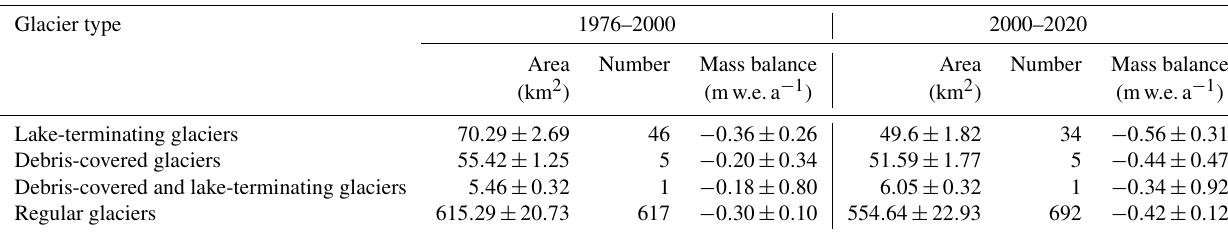
Table 3. Statistics of area, quantity and mass balance of different types of glaciers. Glacier